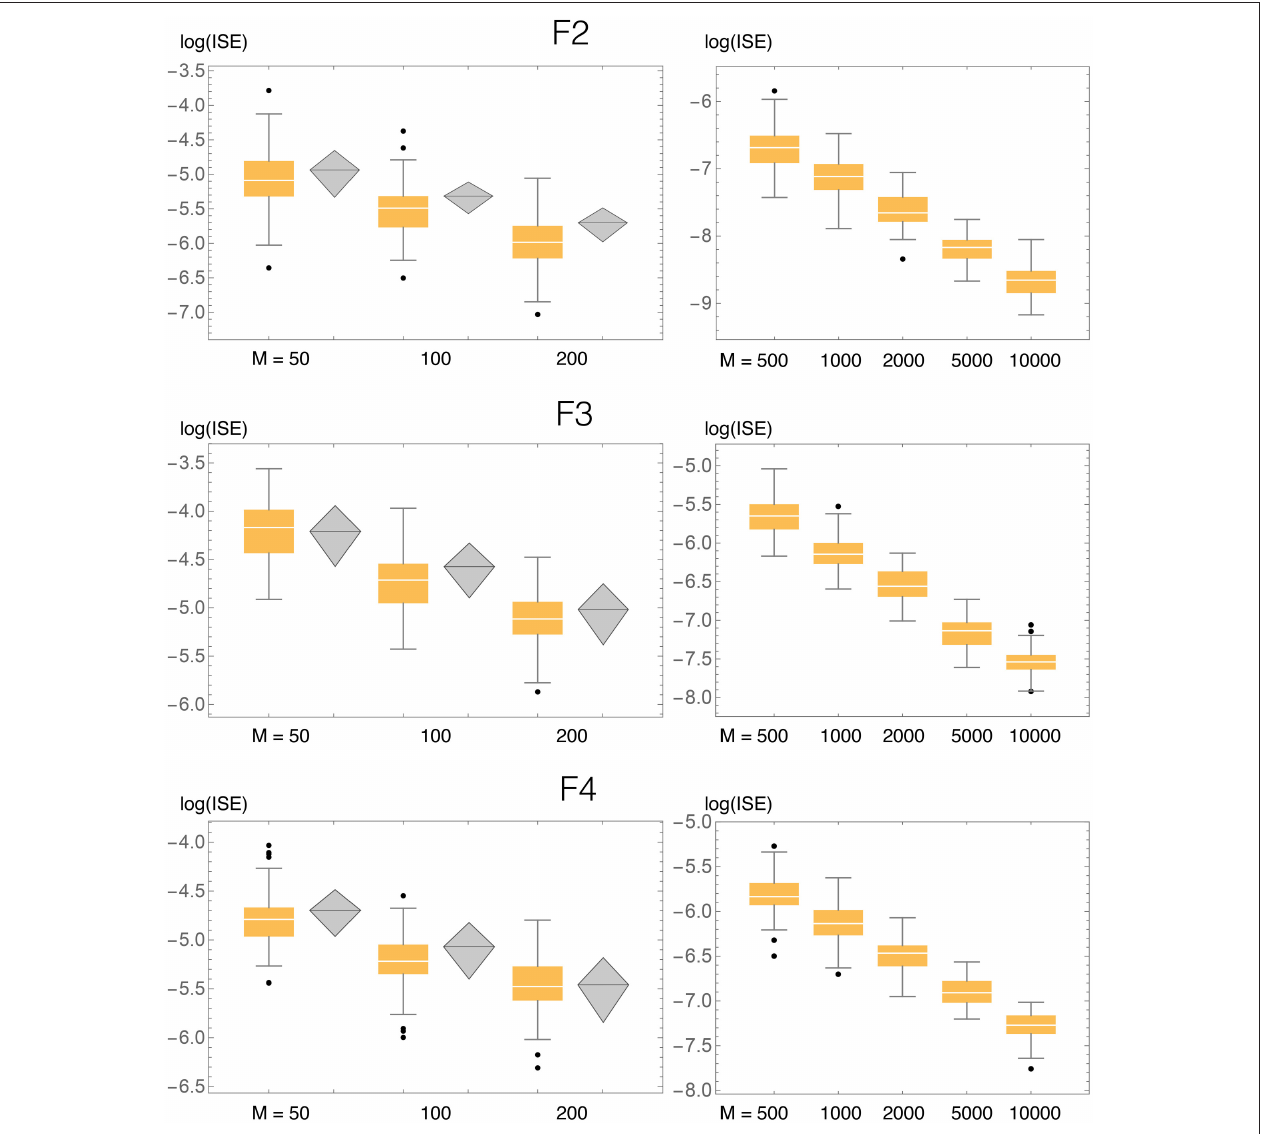
FIGURE 10 | ISE statistics for the three bivariate test densities (F2, F3, F4), comparing our method (BADE, in orange) and BABM (Zougab et al., 2014, in gray). Also shown are results for larger values of the sample size M , not considered by Zougab et al. Their results are shown by gray rhombi representing the mean plus and minus 1 standard deviation, which are the only data they